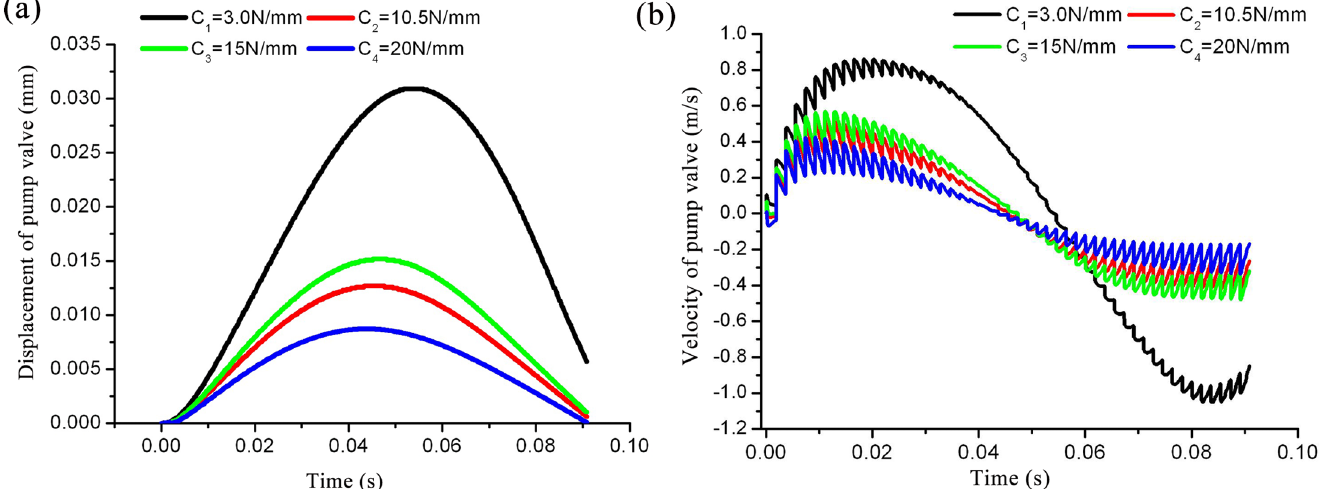
Fig 11. Curve of valve motion as a function of time with different spring stiffnesses. a) Displacement curve comparison; b) velocity curve comparison.